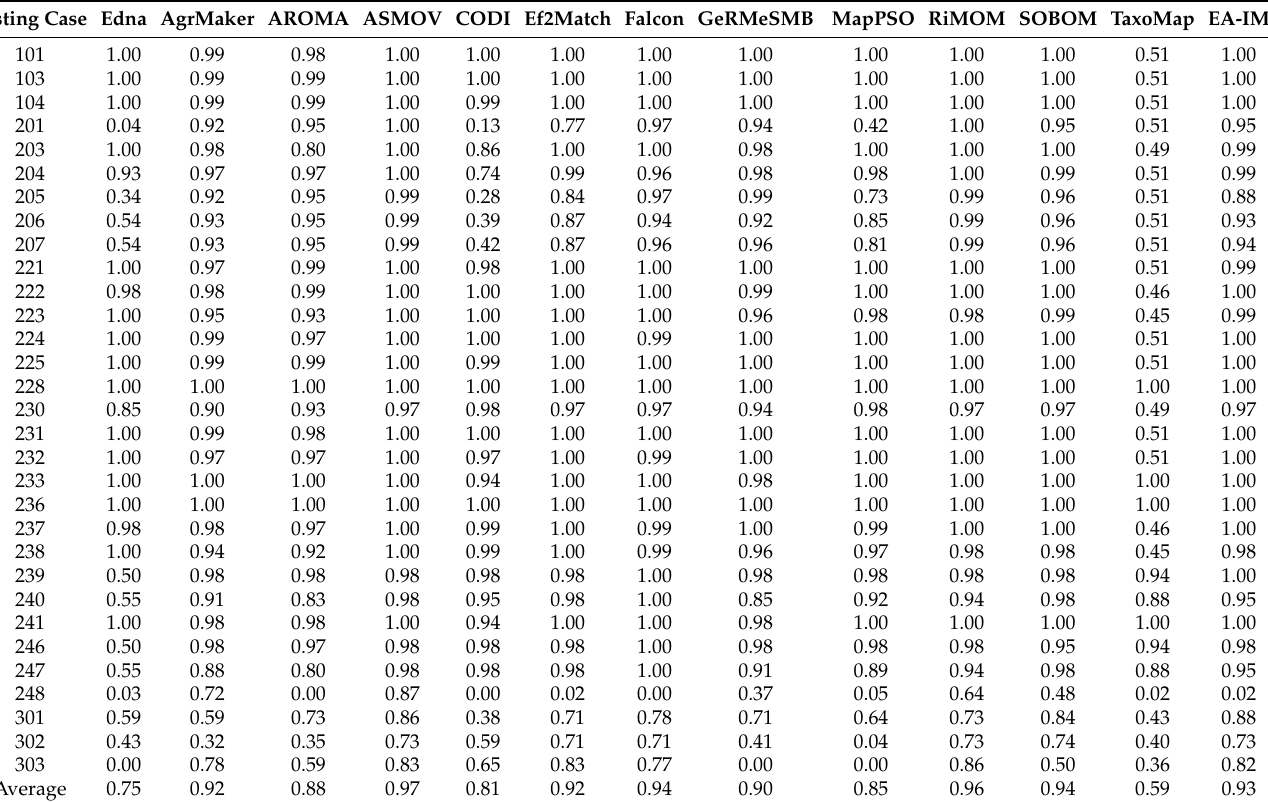
Table 4. Comparison among EA-IM and OAEI’s participants in terms of f-measure on